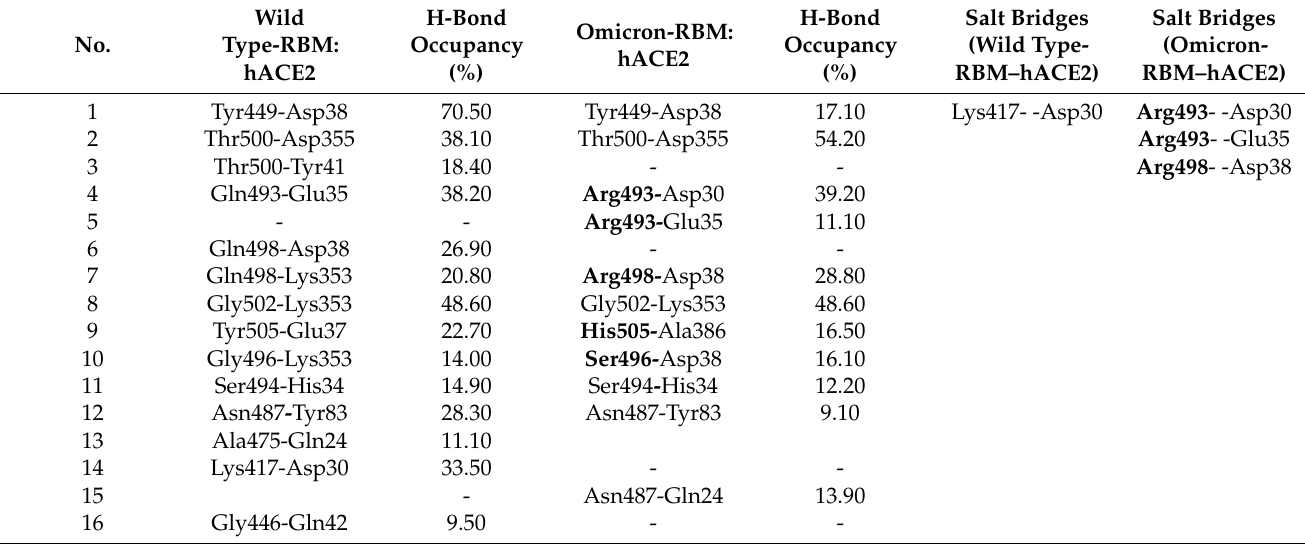
Table 2. Hydrogen bonds and their occupancies and salt bridge ion-pairs found between spike RBM and hACE2 receptor during the entire MD simulation. The mutated residues in the Omicron variant are shown in